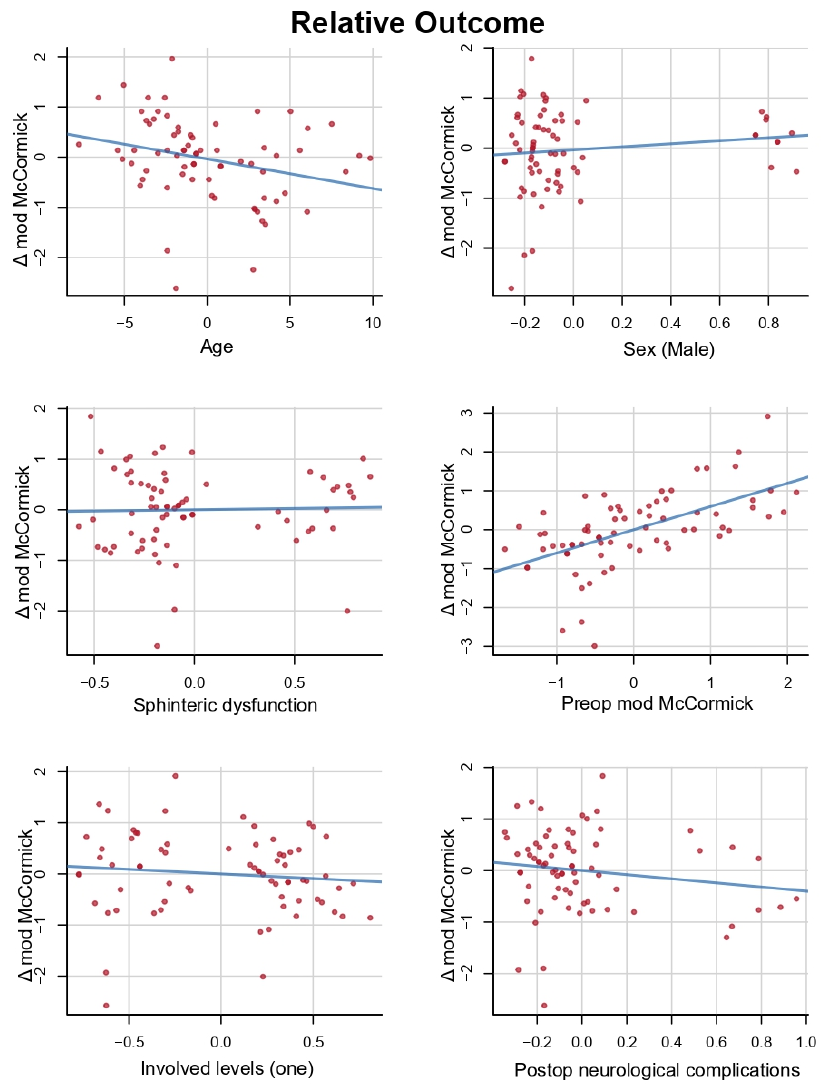
Figure 1. Variables included in the multivariate model for the relative outcome. Multivariate analysis showed that preoperative mod McCormick was the most significant independent predictor of improved outcome ( ∆ mod McCormick, coeff = 0.597, p < 0.0001). Patient’s age showed a statistically significant negative correlation with postoperative improvement ( ∆ mod McCormick, coeff = − 0.058, p < 0.0251).